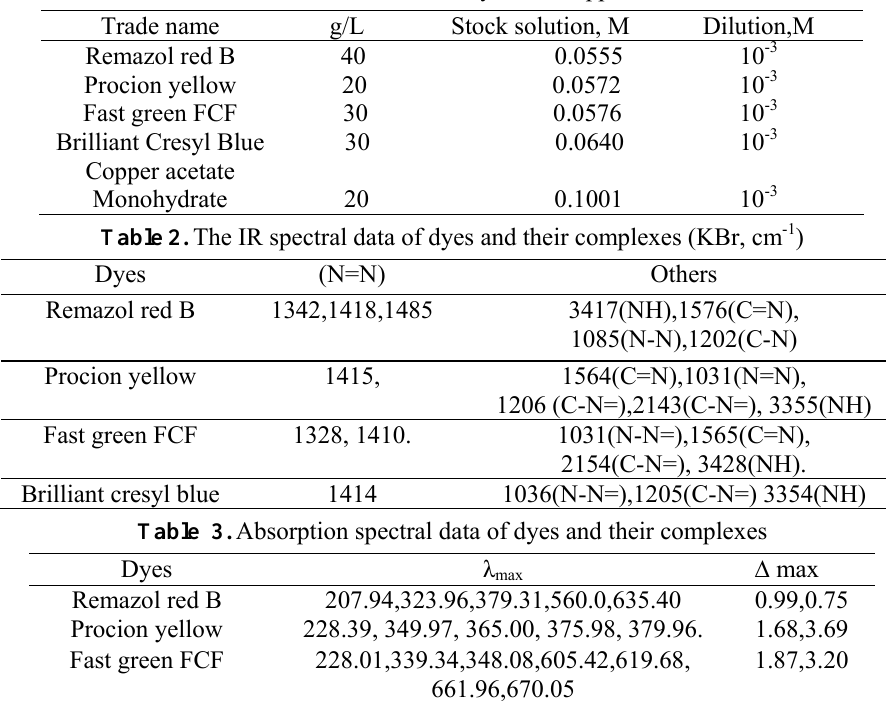
Table 1. Stock solution of dyes and copper acetate